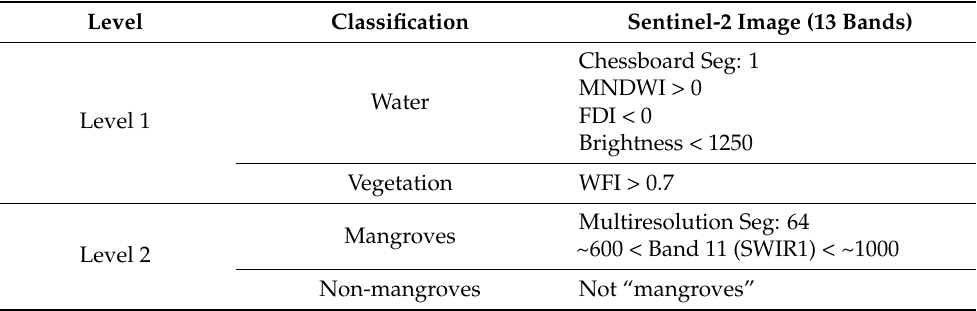
Table 2. Mangrove feature classifications based on Sentinel-2 imagery using MNDWI (Modified